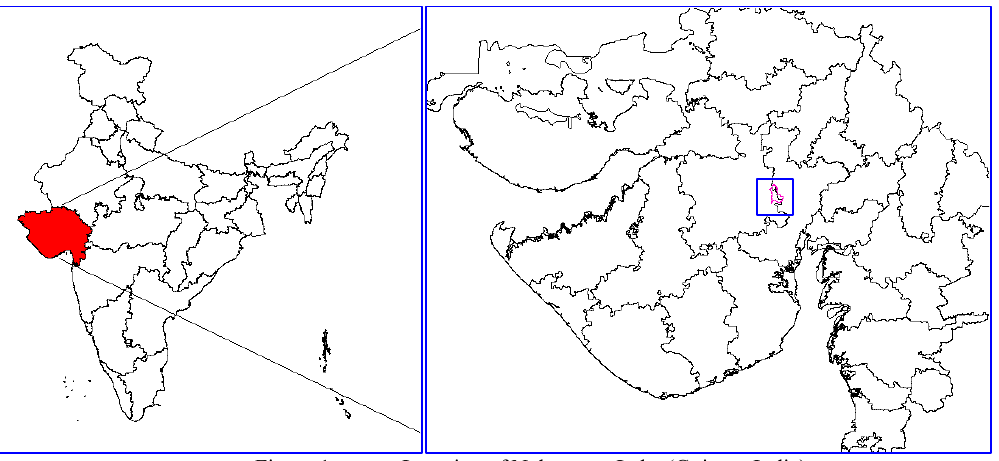
200Figure 1: Location of Nalsarovar Lake (Gujarat, India)